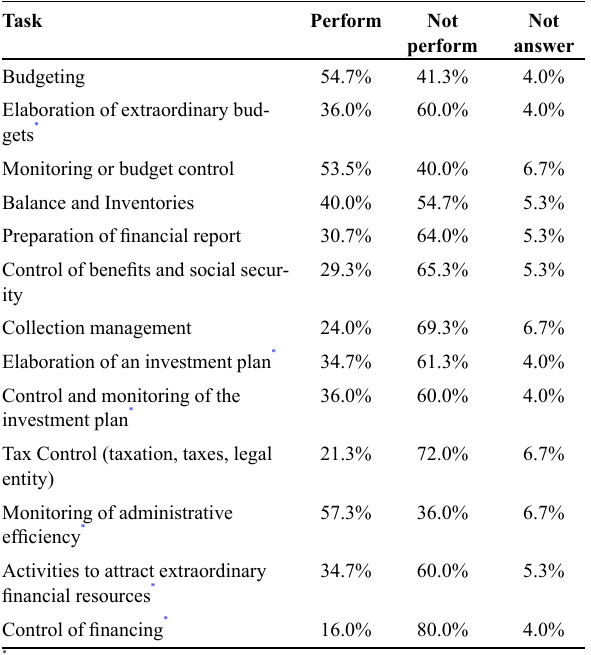
Table 3 - Percentage of frequency of accomplishment of the tasks of the area of Economic-Administrative